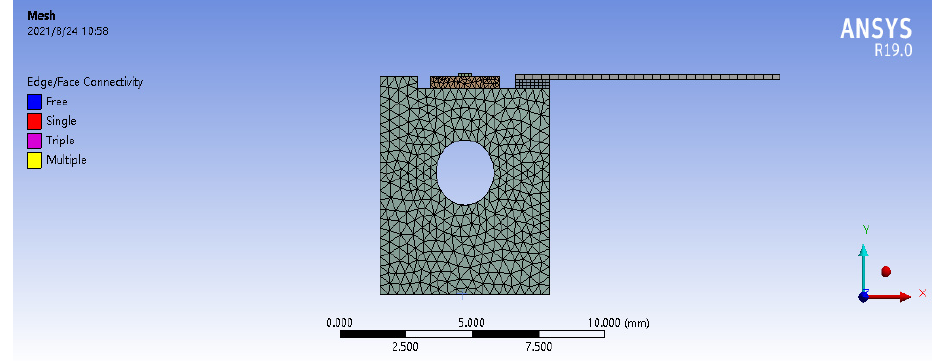
Figure 3. Mesh division diagram.